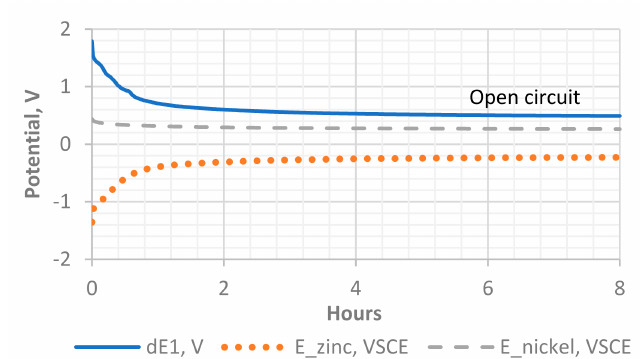
Figure 11. The open-circuit potential of the Ni–Zn cell during discharge. Curve dE1 represents the potential difference between the cathode and the anode. The potentials of the anode and cathode are indicated by E_zinc and E_nickel, respectively.